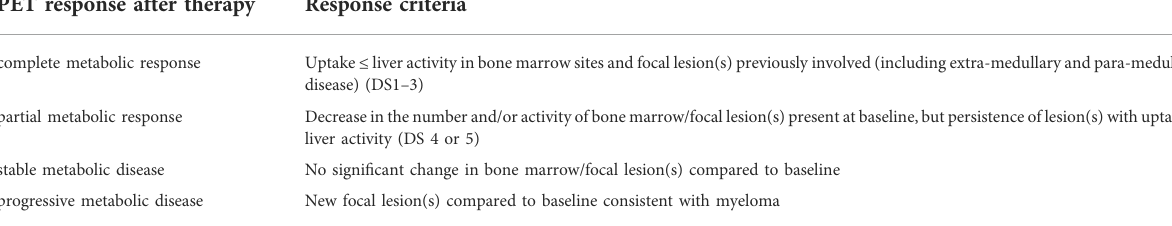
TABLE 1 Proposed re fi nement of the PET response criteria after